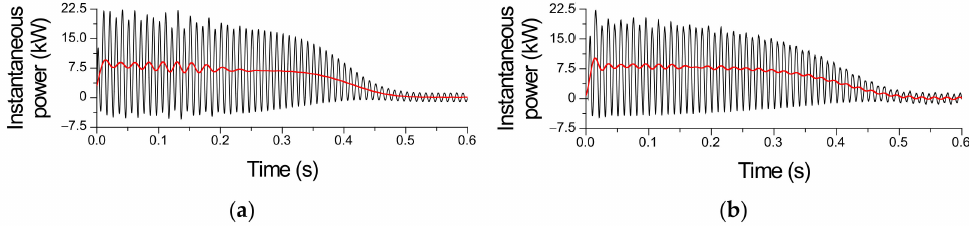
Figure 5. Waveforms of single phase instantaneous power during motor start-up: ( a ) simulated; ( b )